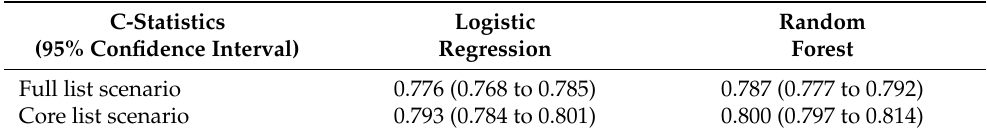
Table 4. Comparison of the predictive model